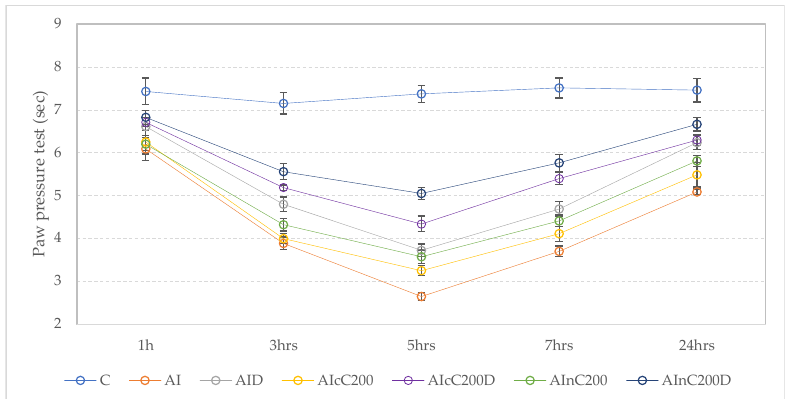
Figure 2. Effects of diclofenac sodium (D), conventional curcumin (cC) and curcumin nanoparticles (nC) on nociceptive thresholds. Circles represent the mean value of each group; whiskers represent the value of the SEM (standard error of the mean). C—control (n=8); AI—Acute inflammation (n=8); D—Diclofenac sodium (n=8) ; cC—conventional curcumin solution (200 mg/kg b.w.; n=8); nC—curcumin nanoparticles solution (200 mg/kg b.w.; n=8).